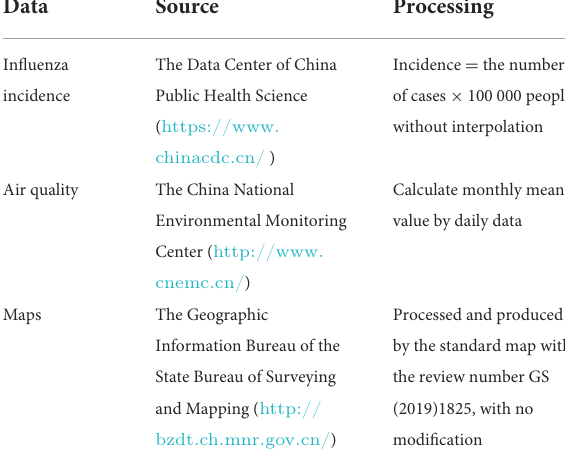
TABLE 1 Data source and